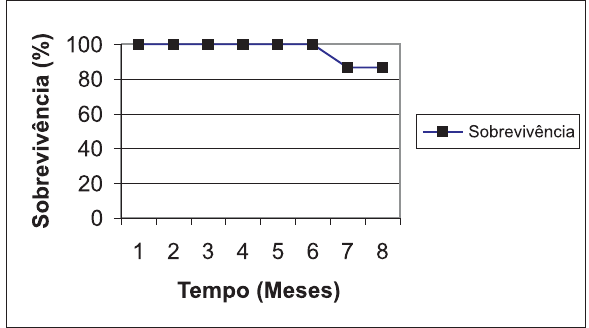
Fig. 5 - Curva de sobrevida acumulada aos oito meses dos quinze primeiros pacientes acima de oitenta anos operados em CEC e sem MAA.